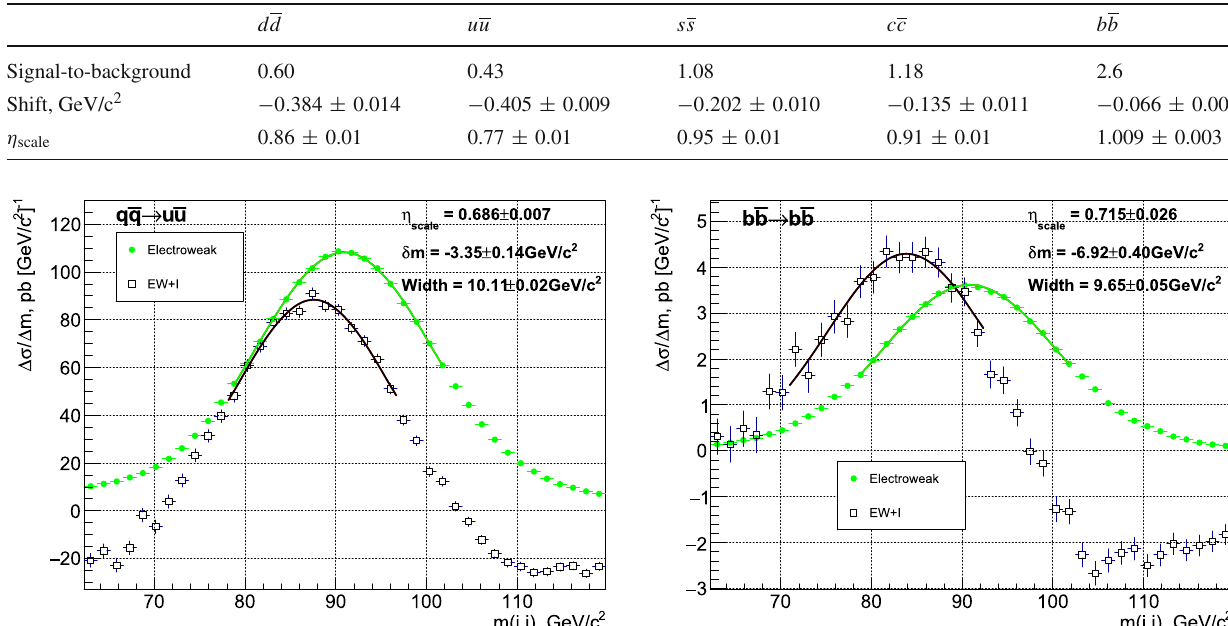
Table 1 Interference effects on the qq → W peak by final state quark flavour. Signal-to-background is defined at the resonance peak without experimental resolution and using only the initial and final states quoted, with negligible statistical error